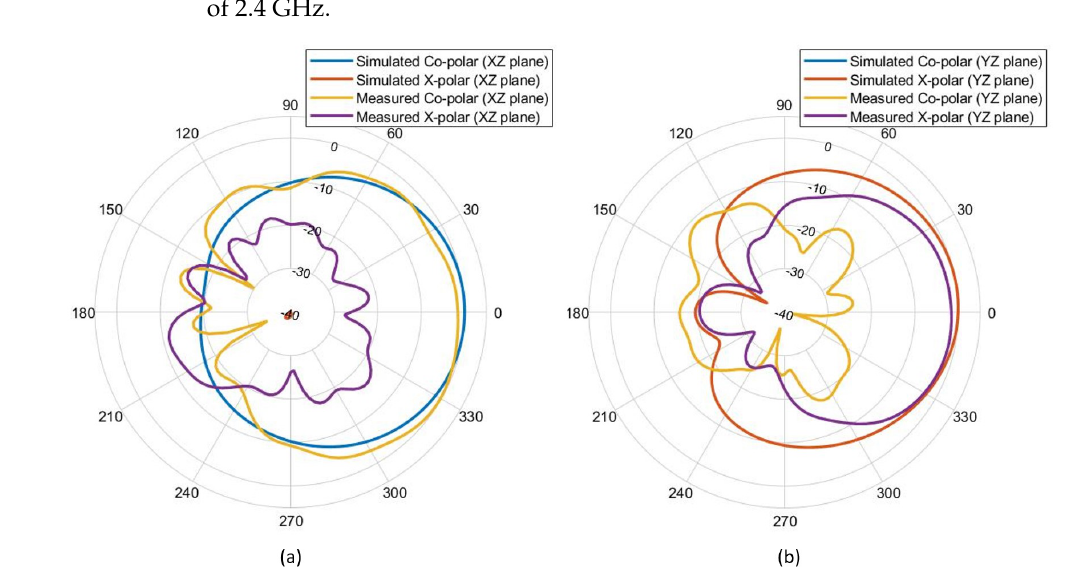
Figure 11. Simulated and measured MPA radiation patterns at 2.4 GHz ( a ) φ = 0 ◦ , ( b ) φ = 90 ◦